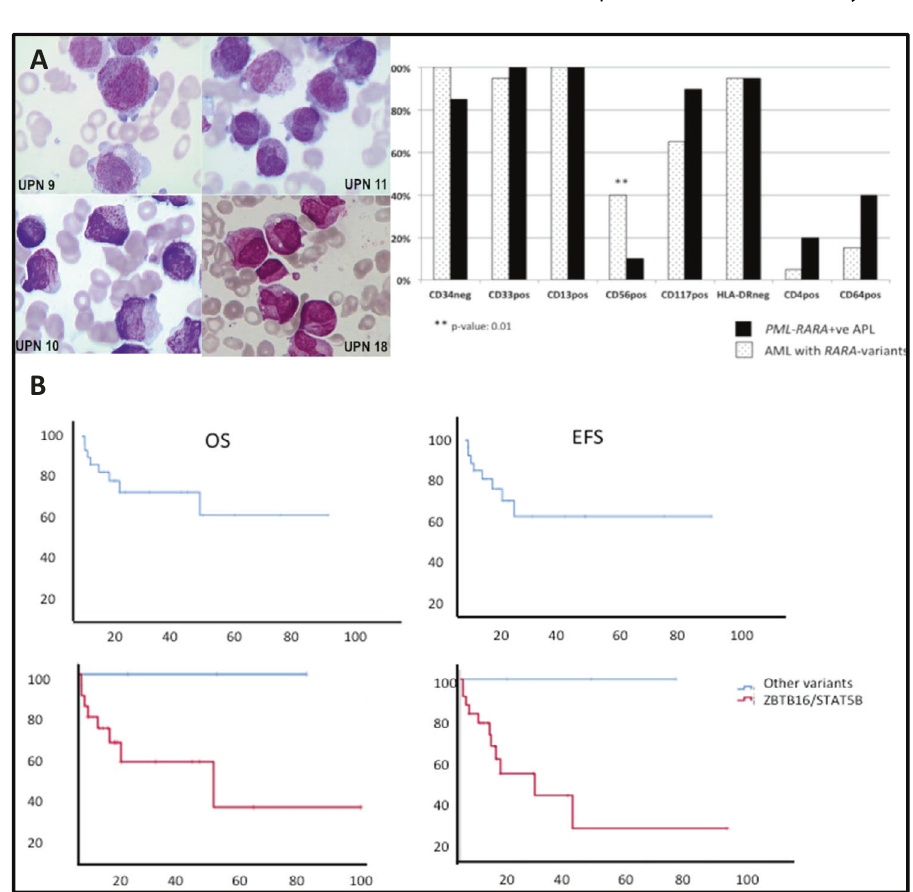
Fig. 1 Biologic characteristics and survival outcomes of leukemias harboring RARA-variants. A Morphologic features of ZBTB16-RARA variant and fl ow cytometry characteristics of AML with RARA variants and PML-RARA-positive APL. The majority of blasts have hypergranular cytoplasm; in a minority of cases, Auer rods were present (UPN10 and UPN18). The majority of blasts harbored a regular round or oval nucleus that was more suggestive of FAB type M2; however, a minority of blasts in UPN 11 and UPN 18 showed irregular and indented nuclei. B Survival outcome of patients with RARA variant